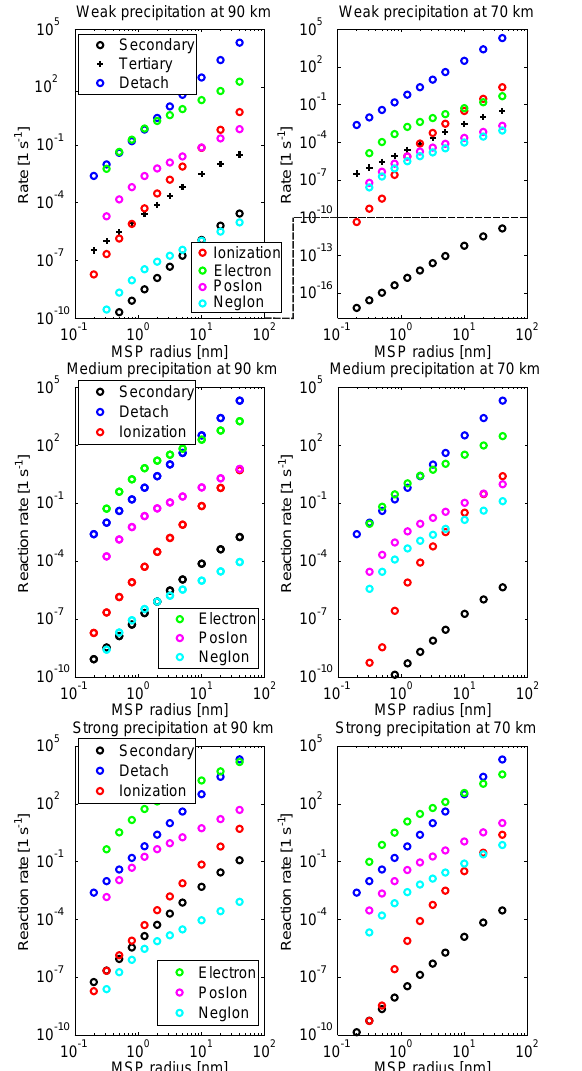
Figure 4. Charging rates of different particle sizes corresponding to the weak (top), medium (middle) and strong (bottom) electron precipitation case for secondary electron emission (black); particle ionization (red); electron detachment from negatively charged par- ticles (blue; and electron (green), negative (cyan) and positive ion attachment (magenta) for ionospheric conditions at 90km (left) and 70km (right)